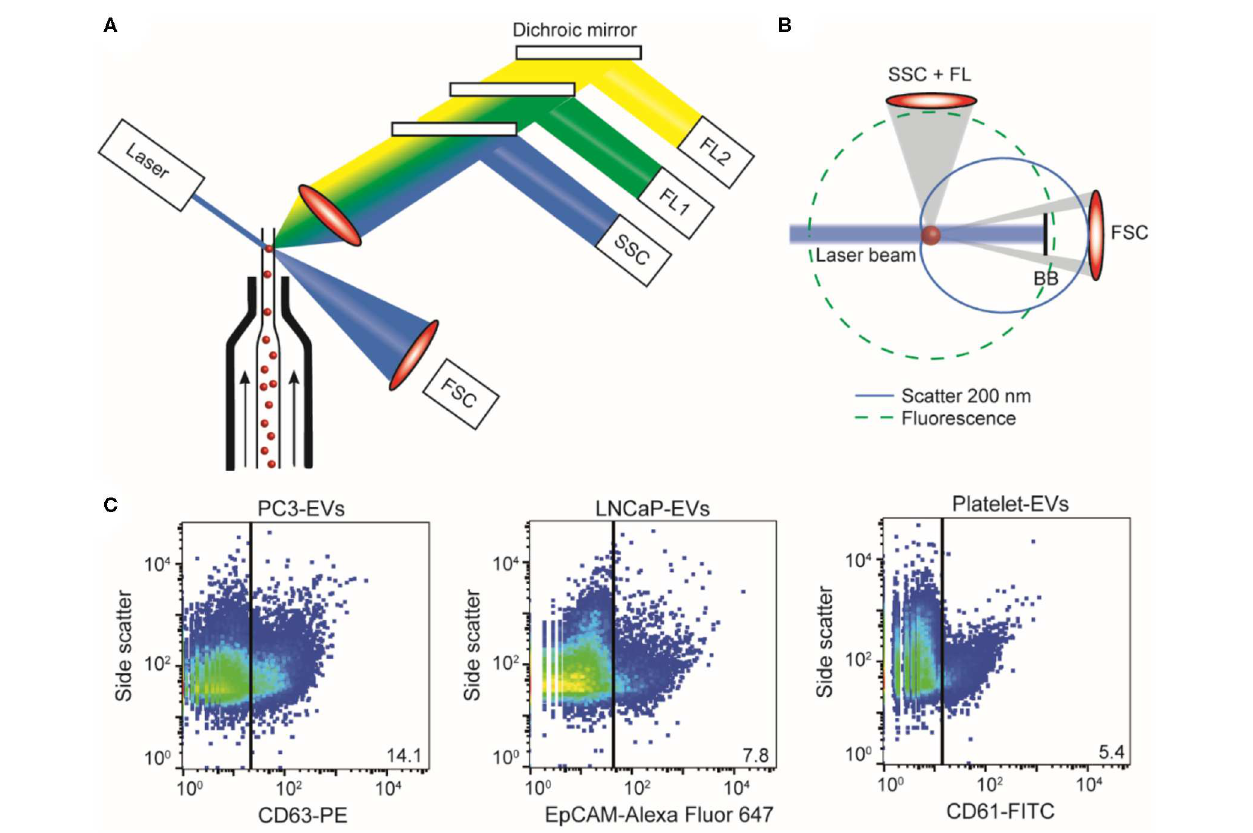
FIGURE 11 | Flow cytometry of extracellular vesicle (EV) samples. (A) In flow cytometry, a single particle suspension is hydrodynamically focused with sheath fluid (arrows) to intersect a laser. Light coming from the particle is collected by a forward scatter detector (FSC), a side scatter detector (SSC), and multiple fluorescence detectors (FL1, FL2, etc.). (B) Fluorescence (green dashed line) is isotropic and can be used to determine antigen expression and cellular origin. Scatter (blue solid line) has an angular distribution that depends on the size and refractive index of the particle (here, 200nm polystyrene). Knowledge of the flow cytometer collection angles and Mie theory allows derivation of particle size and refractive index from the measured scatter signals (14, 20). (C) Scatter plots of side scatter vs. fluorescence for the PC3EV sample stained with CD63-PE (left), the LNCaP EV sample stained with EpCAM-Alexa Fluor 647 (center), and the platelet EV sample stained with CD61-FITC (right). In PC3EV sample, 14.1% was found to be positive for the EV marker CD63; in the LNCaP EV sample, 7.8% was found to be positive for cell surface epithelial marker EpCAM; and in the platelet EV sample, 5.4% of the particles was found to be positive for CD61. BB, blocker bar; FL, fluorescence.